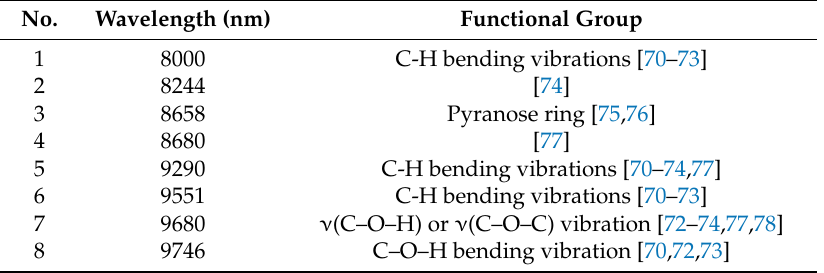
Table 2. Absorption peaks of glucose in the MIR region and the corresponding functional groups.